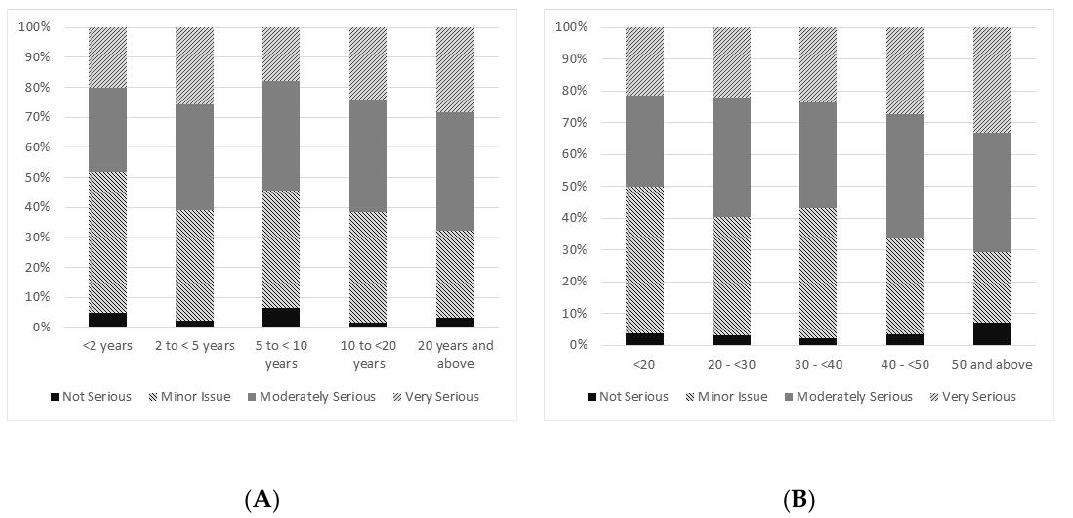
Figure 3. The effect of residential time ( A ) and age ( B ) on the perception of the severity of flood in Wuhan.